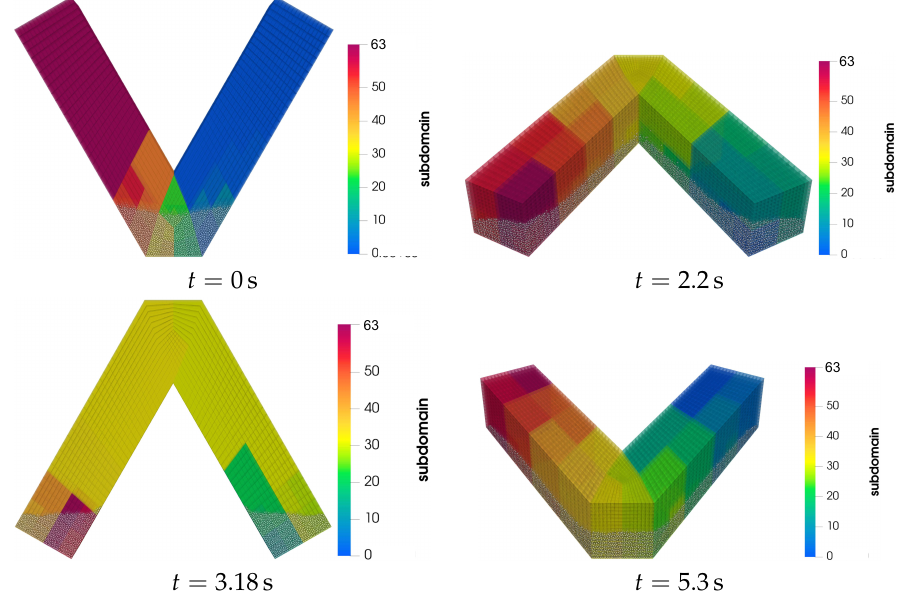
Figure 11. Distribution of subdomains and position of particles during the simulation of V blender on 64 processes with frequent